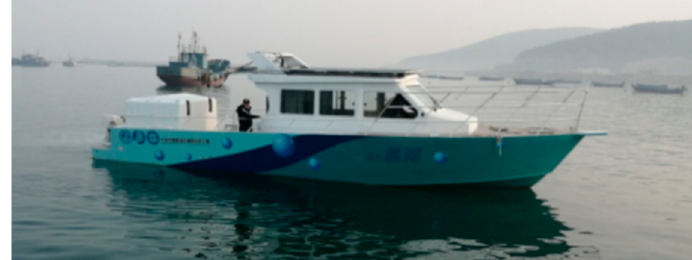
Figure 32. The yacht “Li Hu” [156].